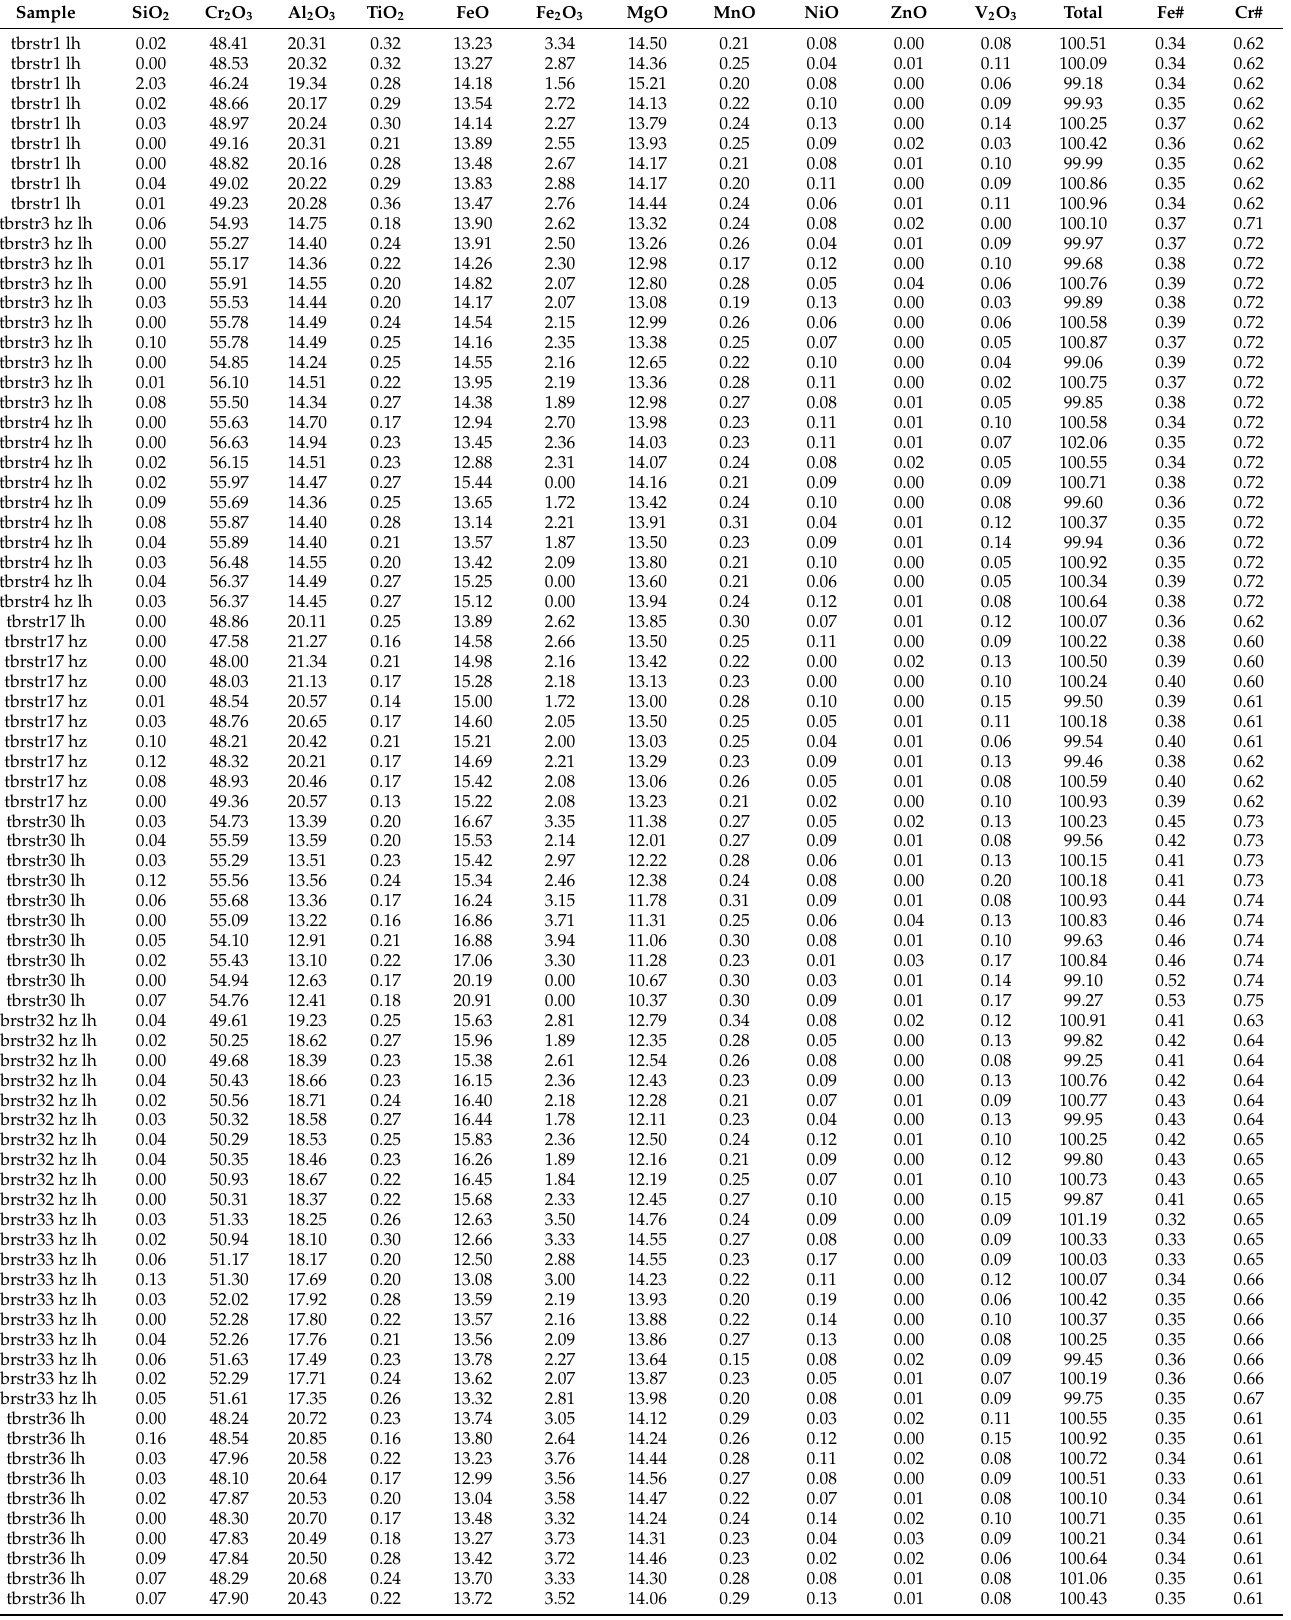
Table 1. Selected microprobe analyses of chromite (wt%) from chromitites of Kabaena Island